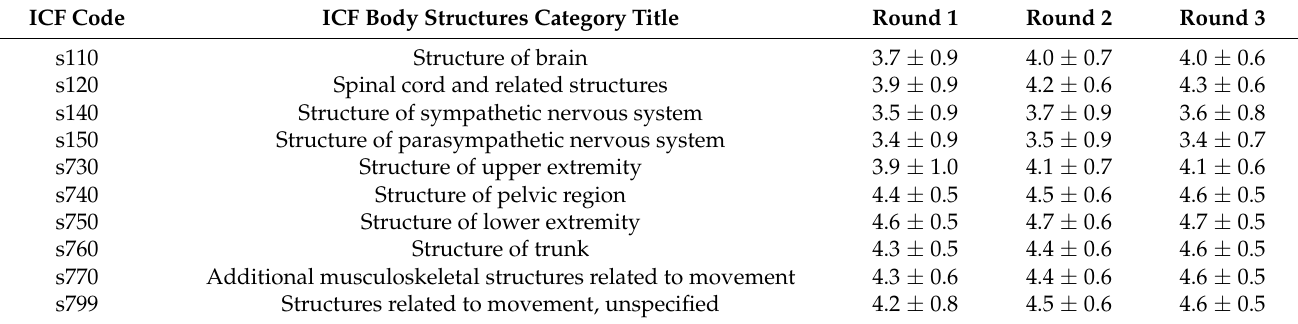
Table 2. Delphi Consensus rating scores of ICF body structure categories for hip fracture rehabilitation.